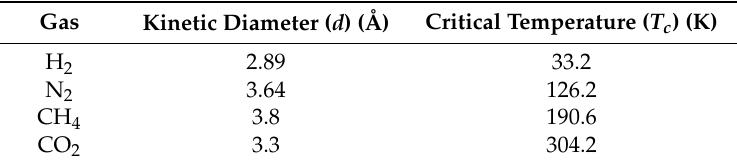
Table 1. Kinetic diameter and critical temperature [20].